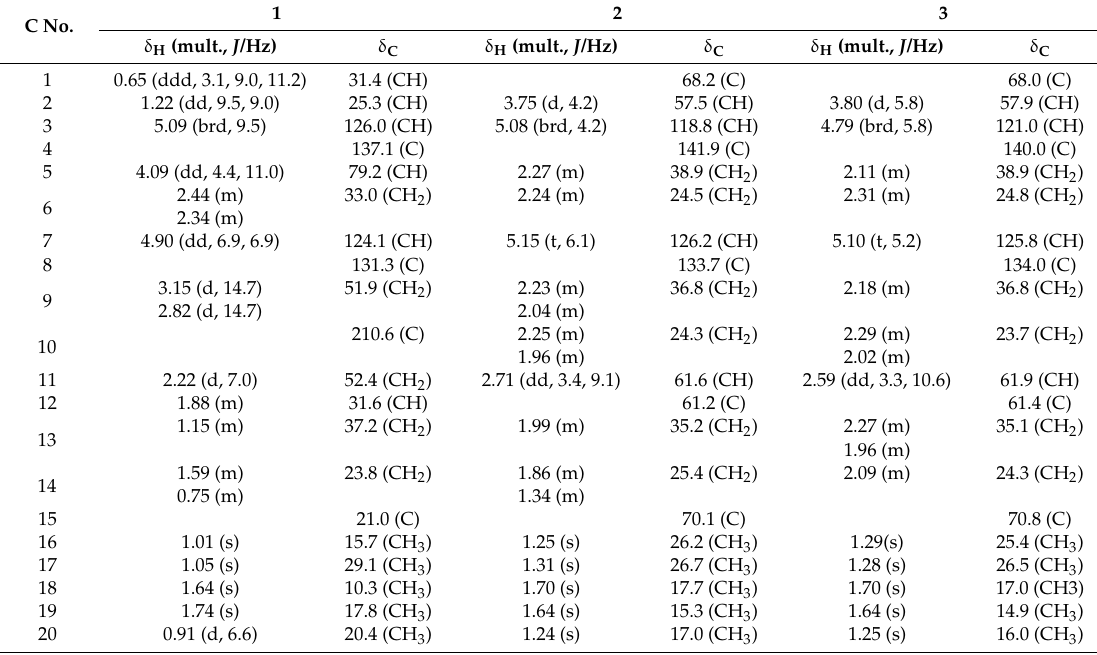
Table 1. 1 H- (500 MHz) and 13 C-(125 MHz) NMR data for 1 – 3 in CDCl 3 . C